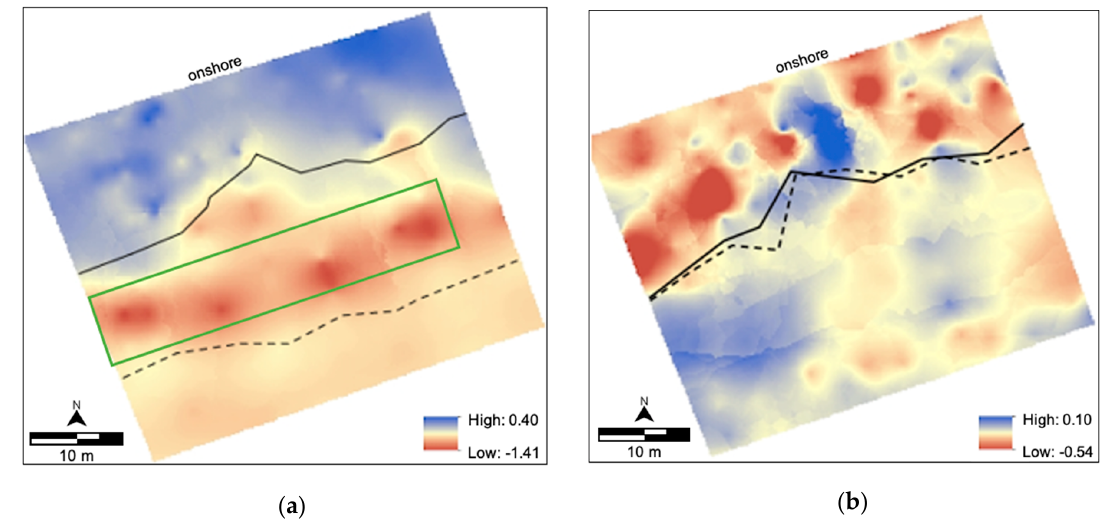
Figure 8. Site B DEM change maps for Hurricanes ( a ) Irma and ( b ) Florence . The dashed and solid lines show the pre- and post-storm dune toe lines, respectively.